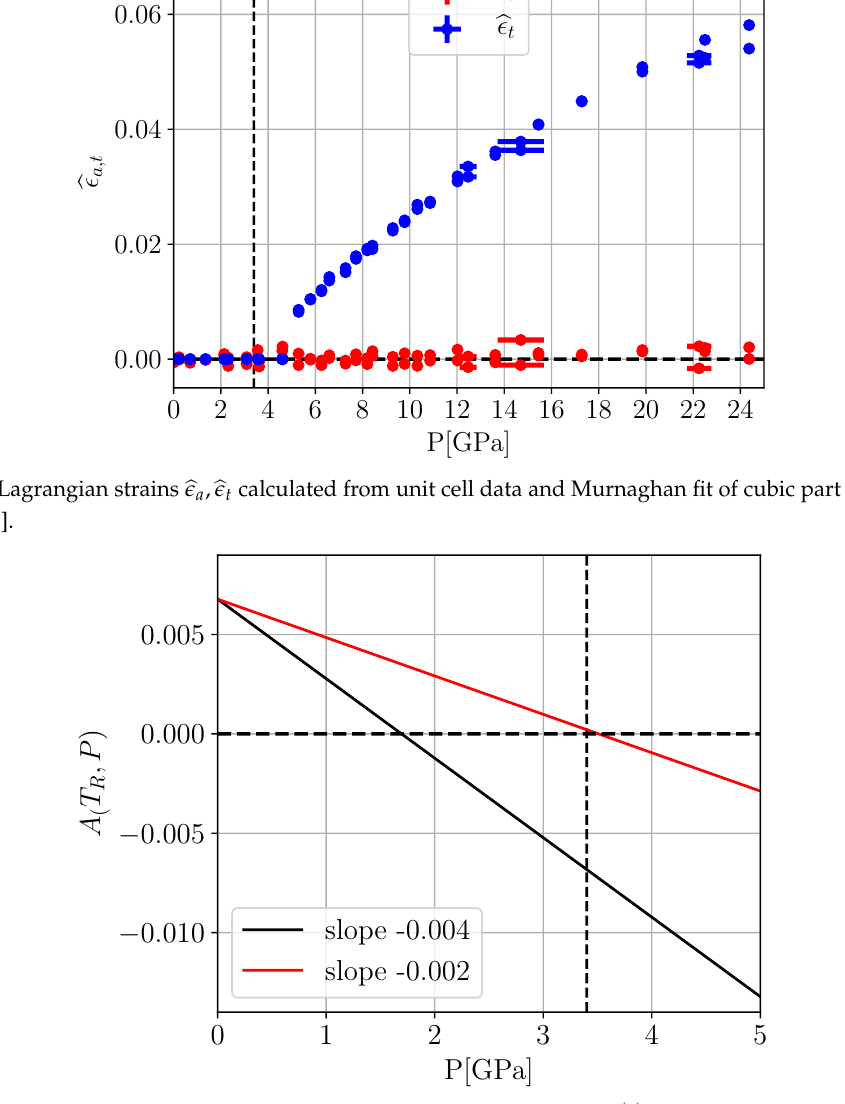
Figure 6. A R ( T = T R , P ) as defined in Equation (10) for correct slope − 2 λ ( 0 ) ( 0 ) ≈ − 0.002 assumed in Ref. to a slope of − 2 λ a / K